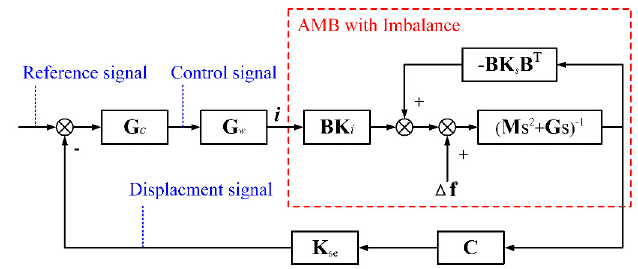
Figure 2. Block diagram of the AMB system with mass imbalance.